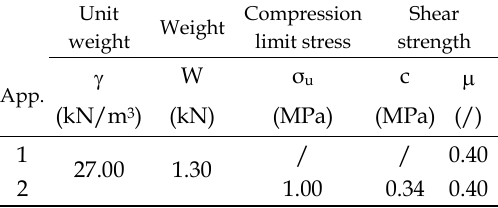
Table 2. Parameters assumed in the calculations. Unit Compression Weight weight limit stress